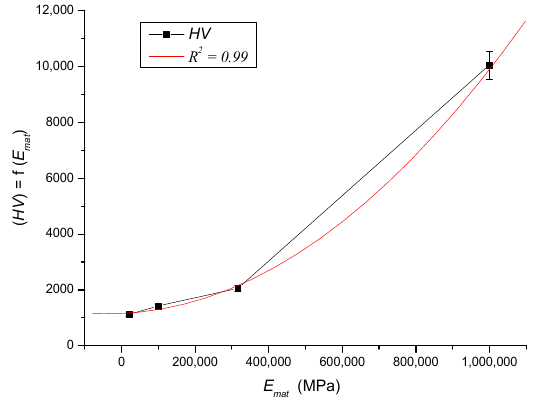
Figure 7. Control comparison of values ( HV ) = f ·( E mat ).